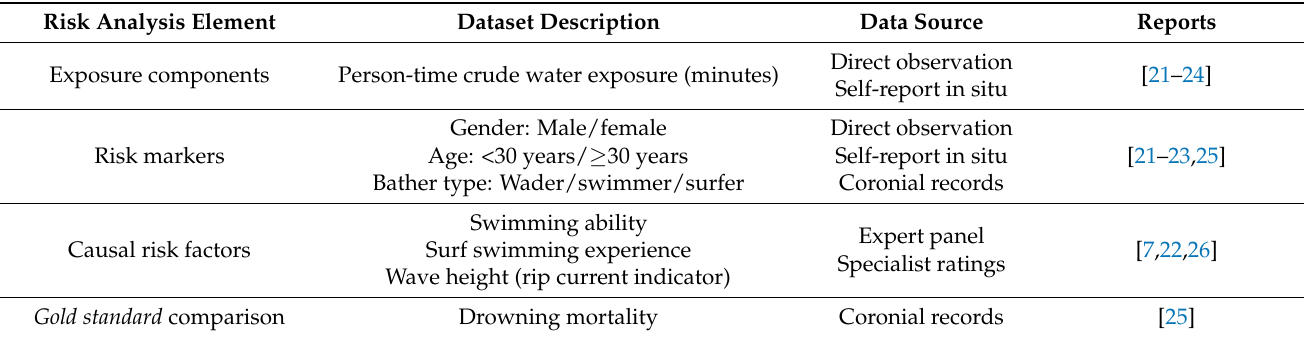
Table 1. Data applied in drowning risk analysis.